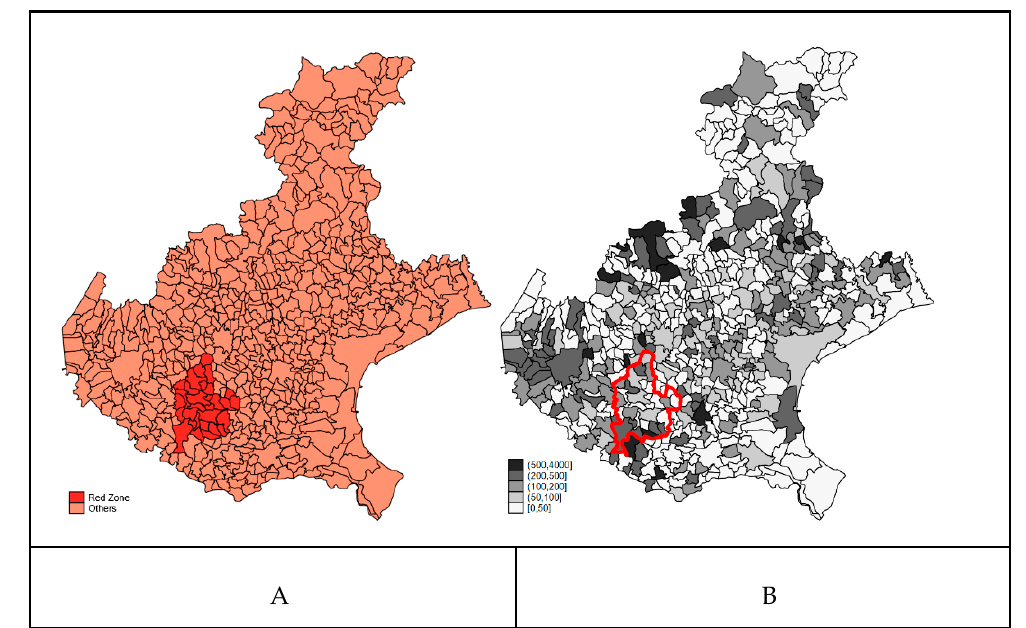
Figure 1. Panel ( A ): Per- and polyfluoroalkyl substances (PFAS) Red Zone in the Veneto Region; Panel ( B ): COVID-19 mortality rate (×100,000) between 21 February and 15 April 2020. Borders of Red Zone are highlighted in red in panel ( B ).